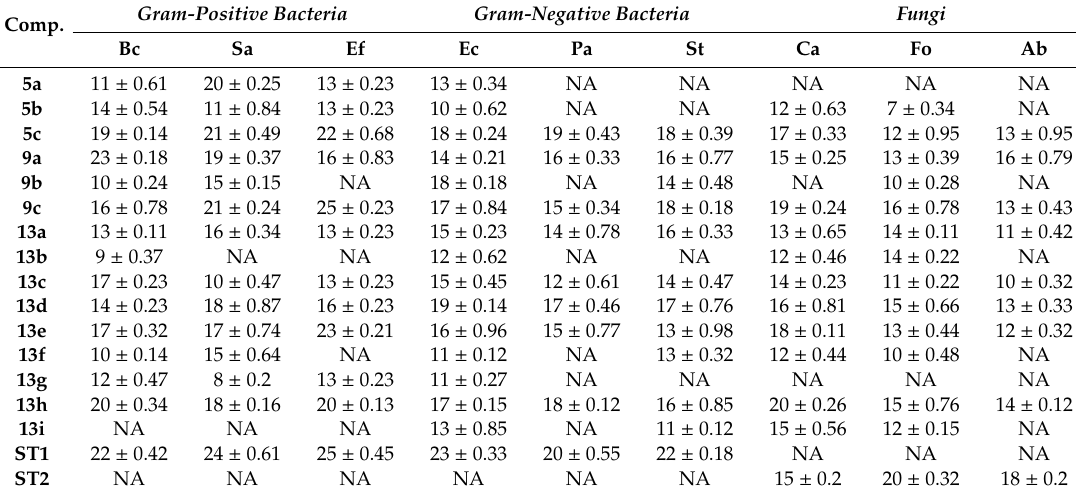
Table 1. Antimicrobial activities of the pyrazolo[1,5- a ]pyrimidines ( 5a – c , 9a – c and 13a – i ) and the reference drugs expressed as inhibition zone (IZ, mm ± standard